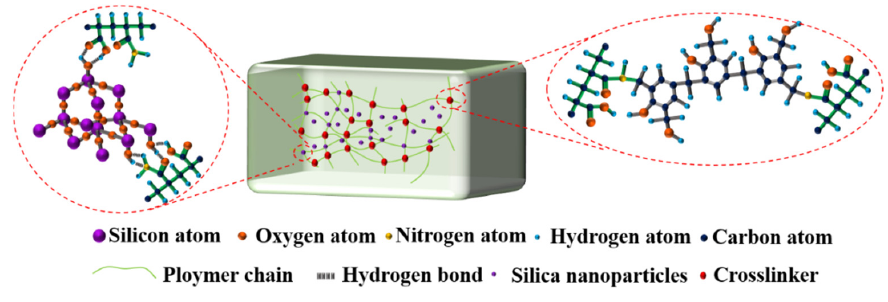
Figure 8. Mechanism through which nanoparticles stabilize a phenolic gel.